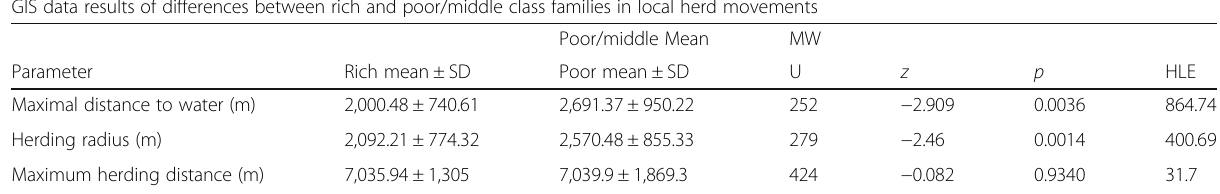
Table 5 Results of Mann-Whitney U test with Hodges-Lehmann effect (HLE) size estimator (between rich and poor/middle class families)